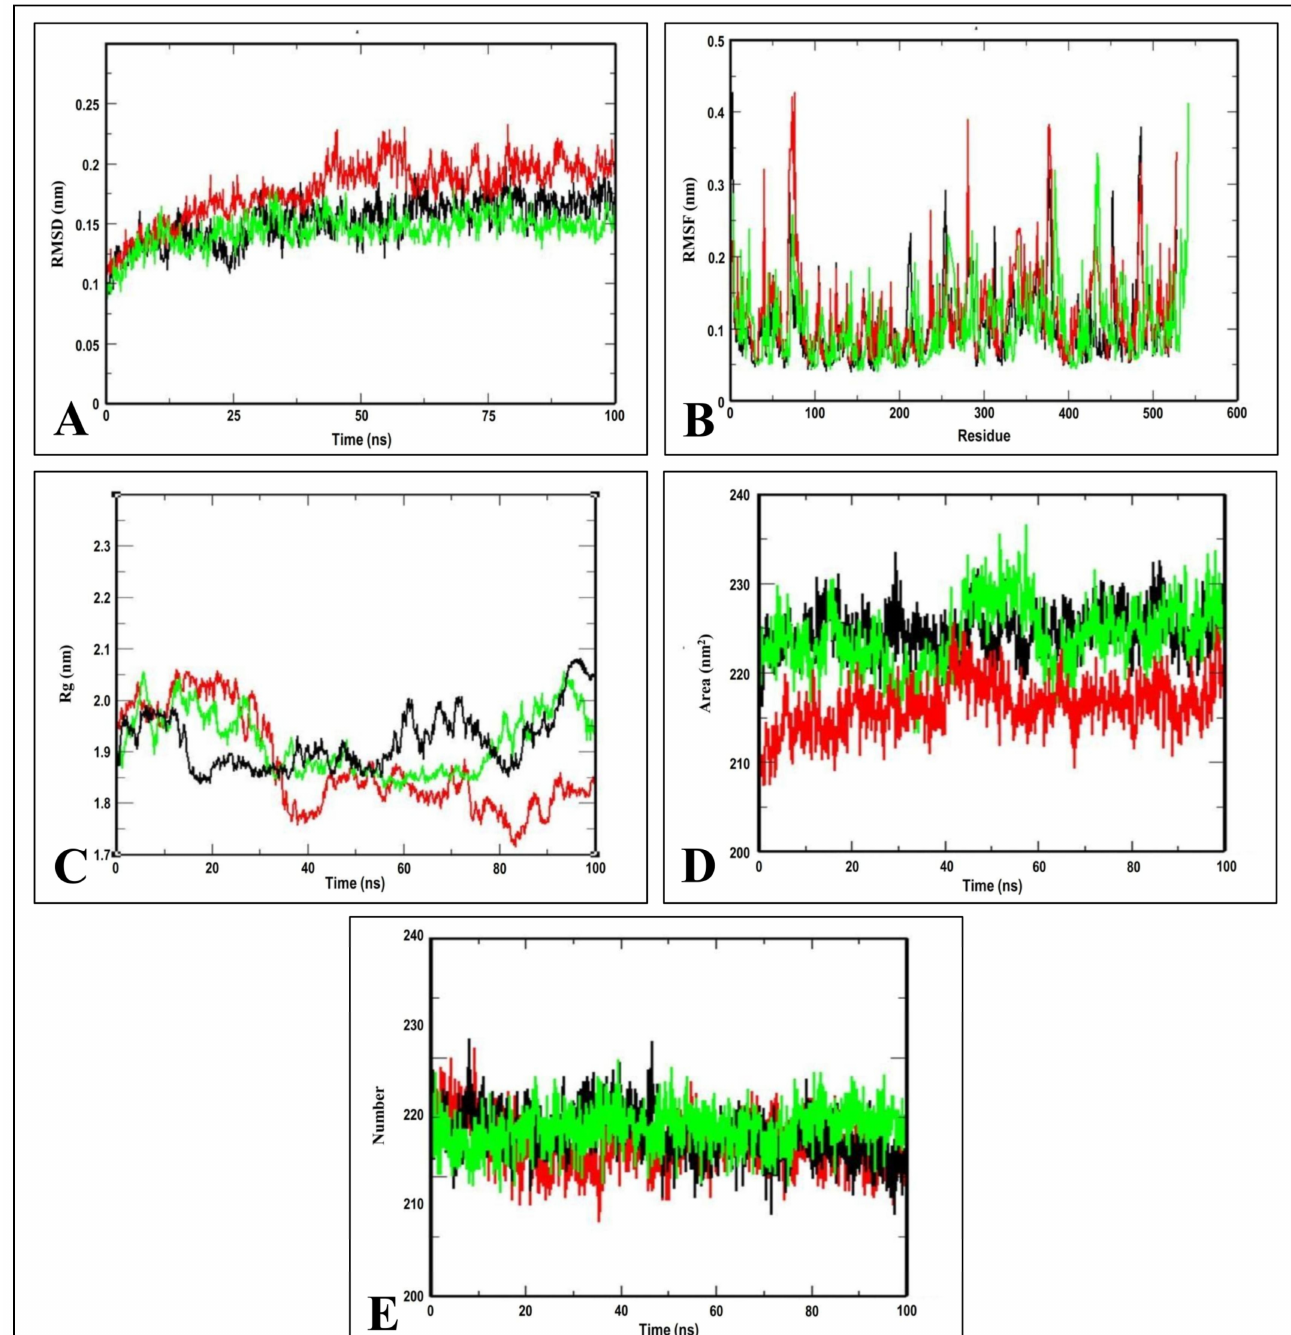
Figure 7. Molecular dynamics simulation of 2W3L protein alone (black), 2W3L–Friedelin complex (green), and 2W3L–Obatoclax complex (red). ( A ) RMSD; ( B ) RMSF; ( C ) Radius of gyration; ( D ) SASA; and ( E ) Hydrogen bond